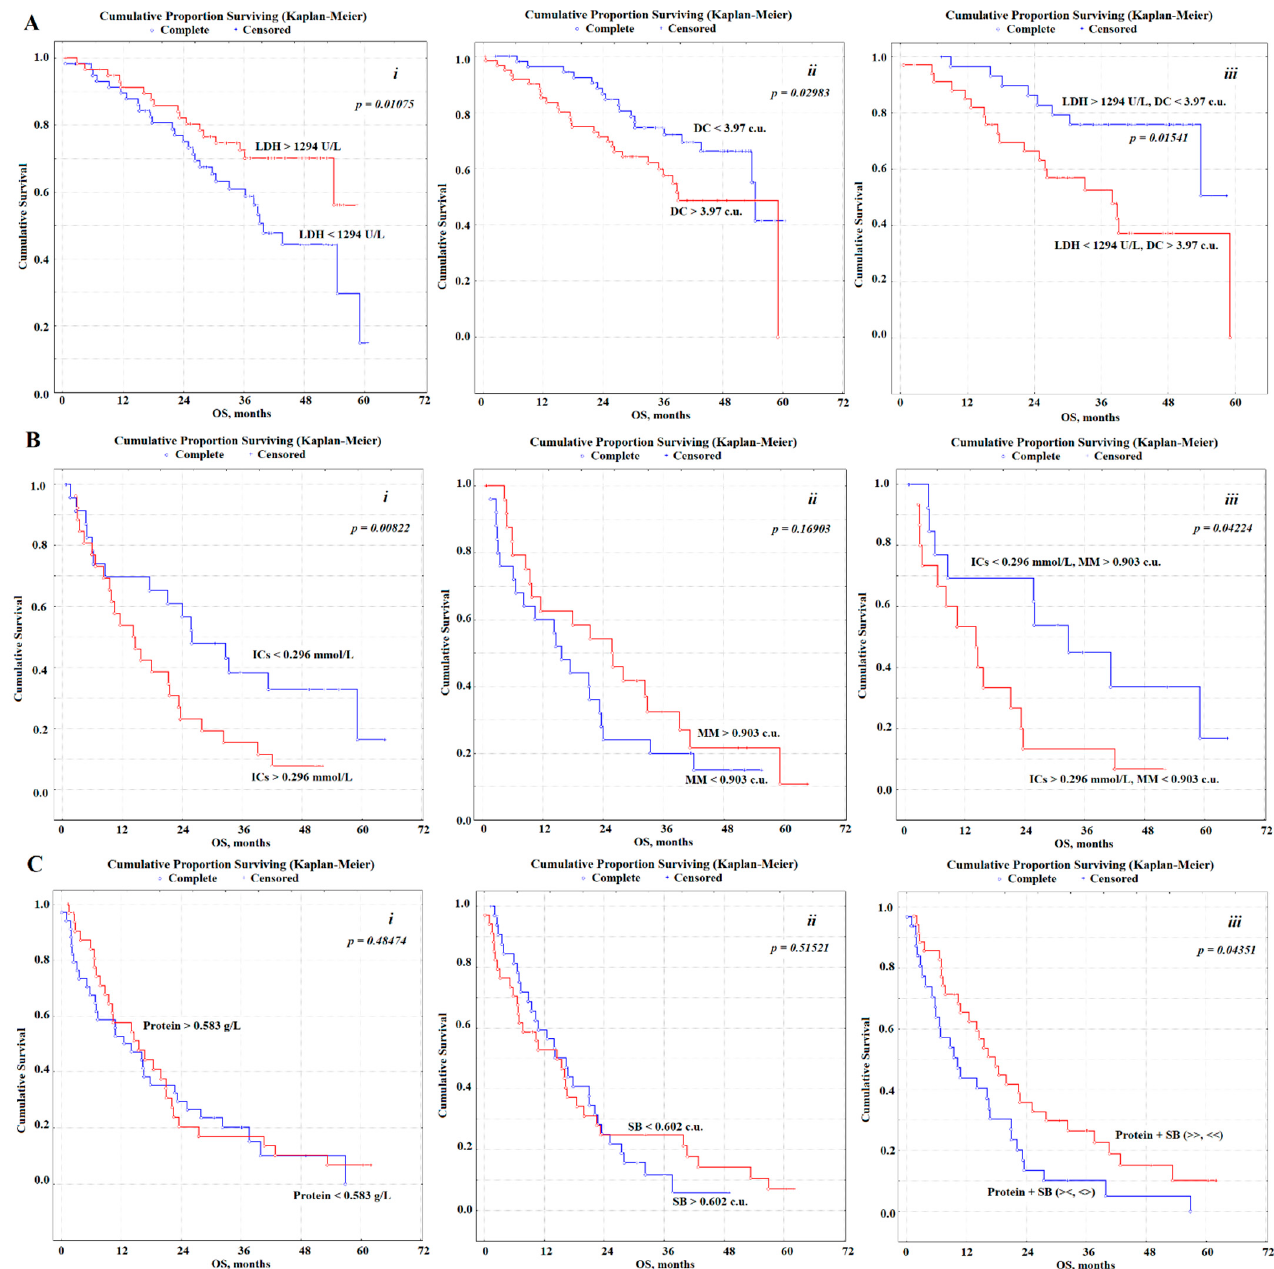
Figure 2. Kaplan–Meier survival curves illustrating the impact of biochemical salivary markers on OS. ( A ): N 0 —LDH ( i ), DC ( ii ) and LDH + DK ( iii ); ( B ): N 1 —ICs ( i ), MM ( ii ) and ICs + MM ( iii ); ( C ): N 2 —Protein ( i ), SB ( ii ) and Protein + SB ( iii ). LDH—lactate dehydrogenase, DC—diene conjugates, ICs—imidazole compounds, MM—middle molecular toxins, SB—Schiff bases.